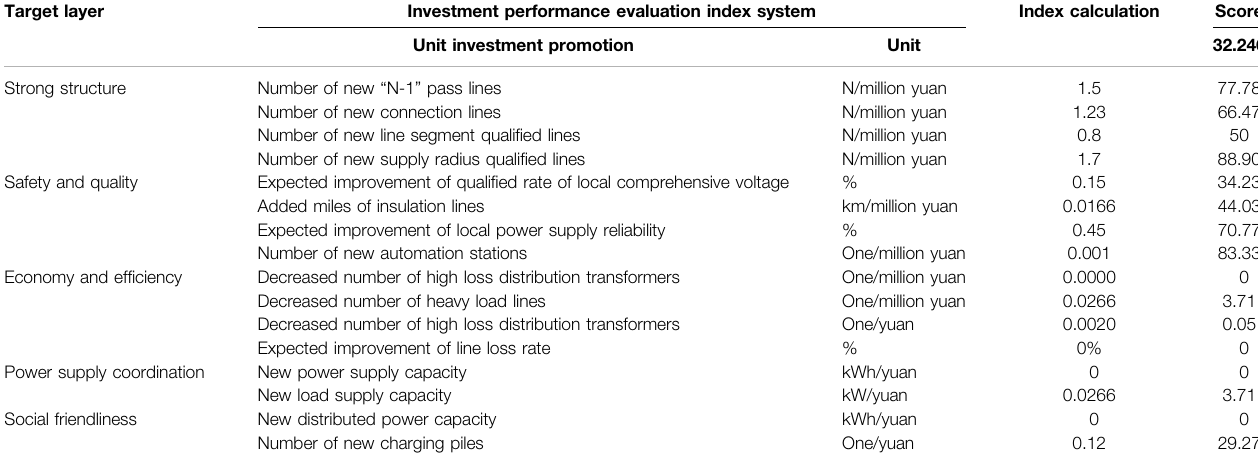
TABLE 4 | Investment bene fi t score of Project 1.